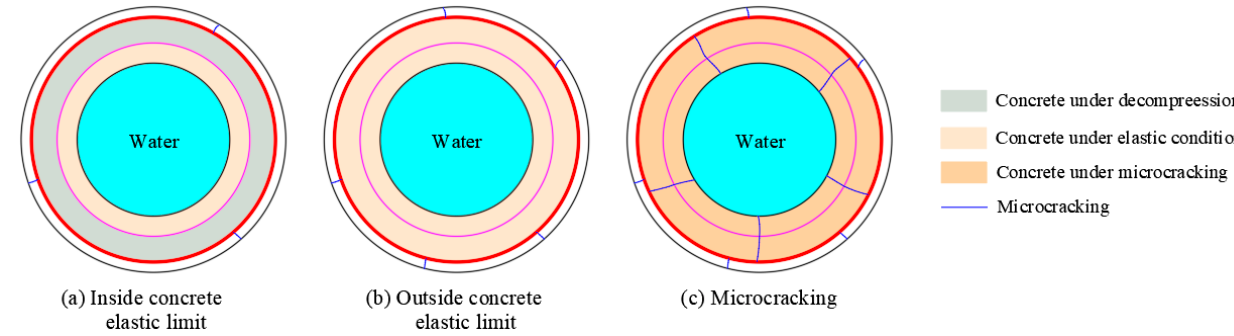
Figure 18. Visible cracking stage. (5) Steel cylinder yield and prestressed steel wire broken (1.9~2.4 MPa) In this stage, the steel cylinder yields and the tensile stress is mainly supported by prestressed steel wire due to the expansion and penetration of concrete cracks. Pre- stressed steel wire successively reaches the yield and ultimate limit states. When the maximum elongation of prestressed steel wire is exceeded, the fracture occurs in the weak part, as shown in Figure 19. Figure 19. Wire broken stage. (6) Burst stage (Exceed 2.4 MPa)